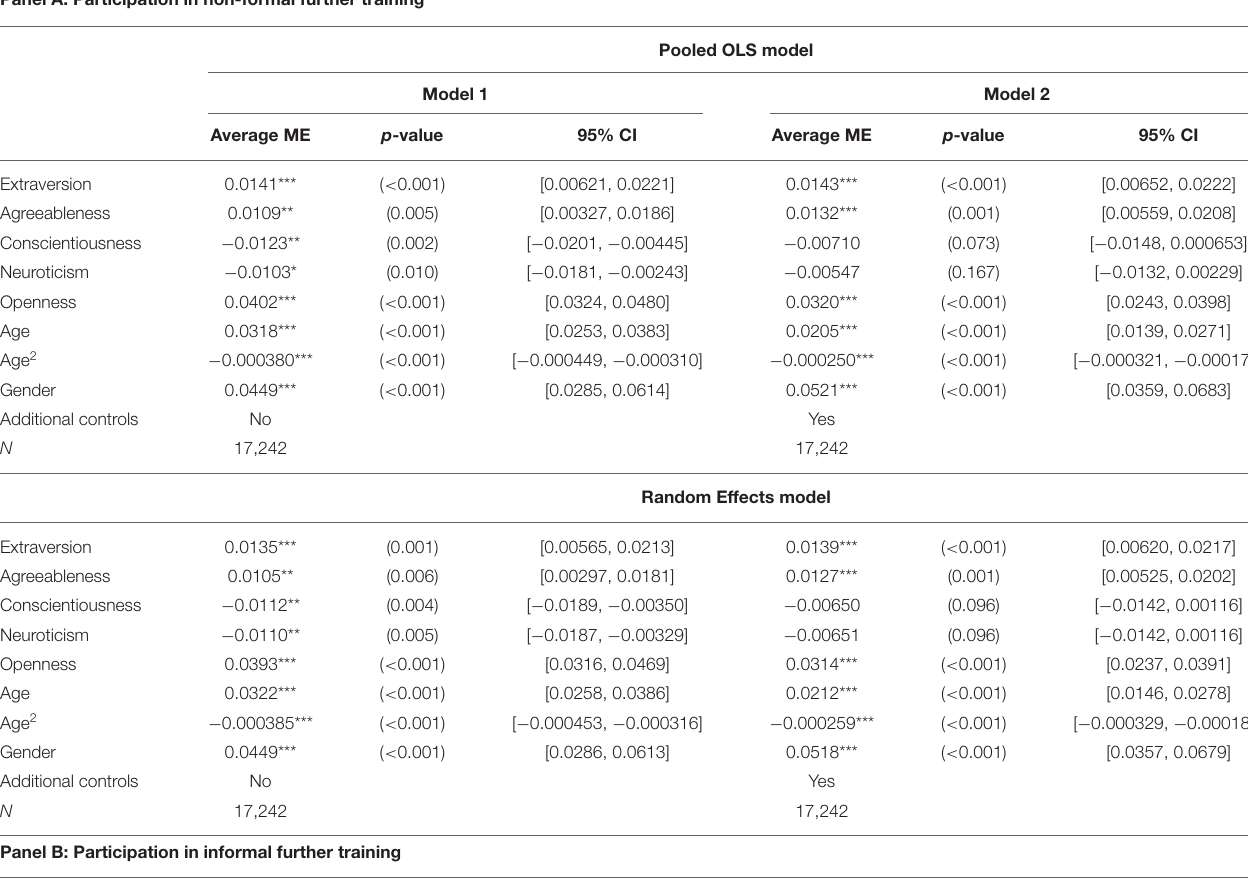
TABLE 7 | Big Five Personality Dimensions and non-formal and informal further training participation. Panel A: Participation in non-formal further